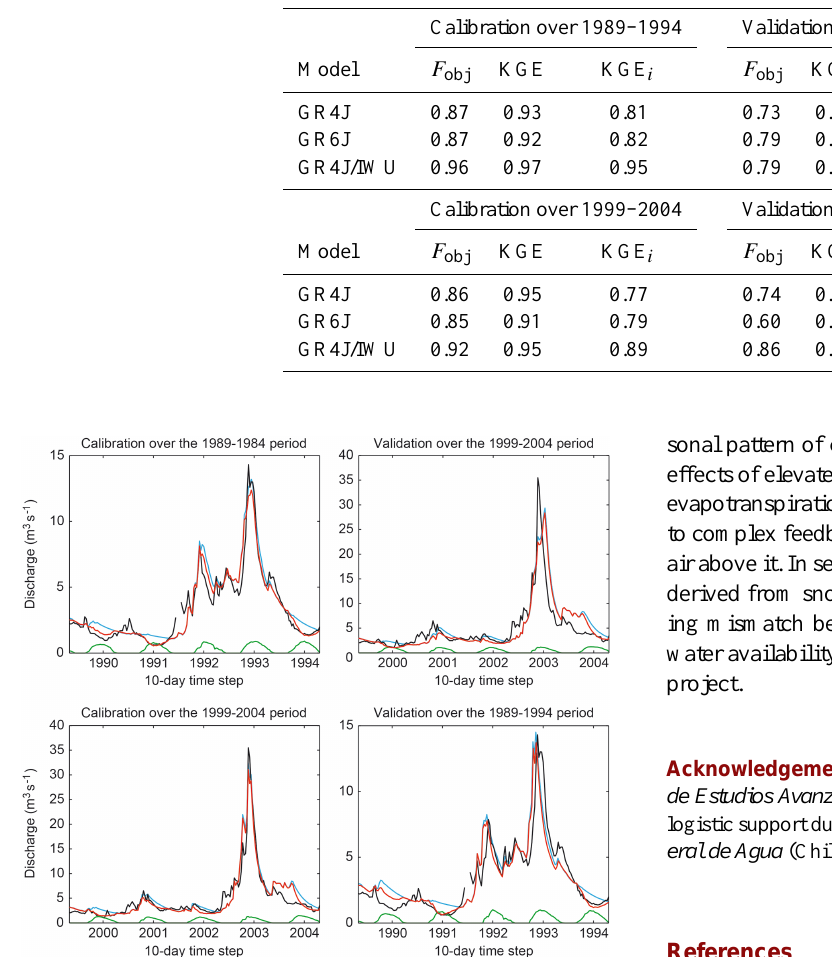
Figure 3. Simulated influenced streamflow (in red) obtained with the GR4J/IWU model compared to observed streamflow (in black) in calibration and validation. Seasonal irrigation water-use (IWU) and the simulated natural streamflow ( Q n , sim ) are plotted in green and blue,